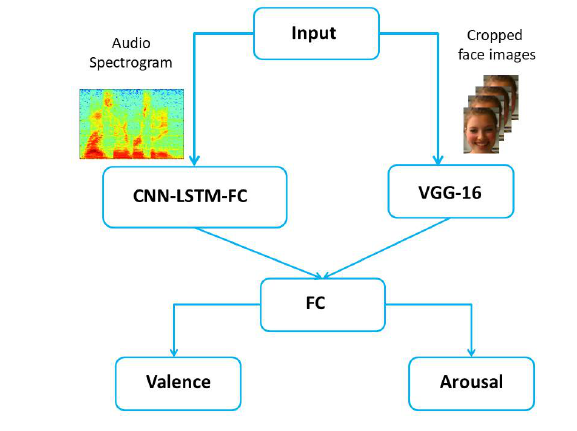
Figure 2 | Deep multitask learning for multimodal speech emotion recognition.